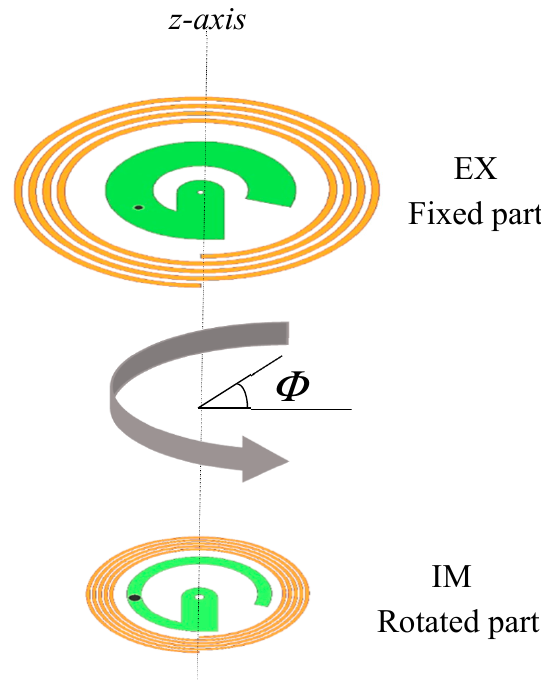
Figure 2. Rotational misalignment setting.